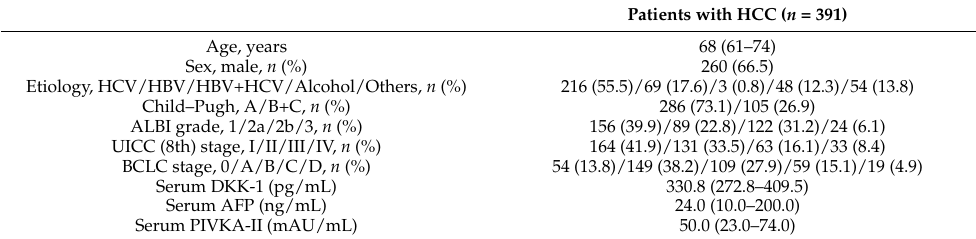
Table 1. Characteristics of patients with hepatocellular carcinoma (HCC).